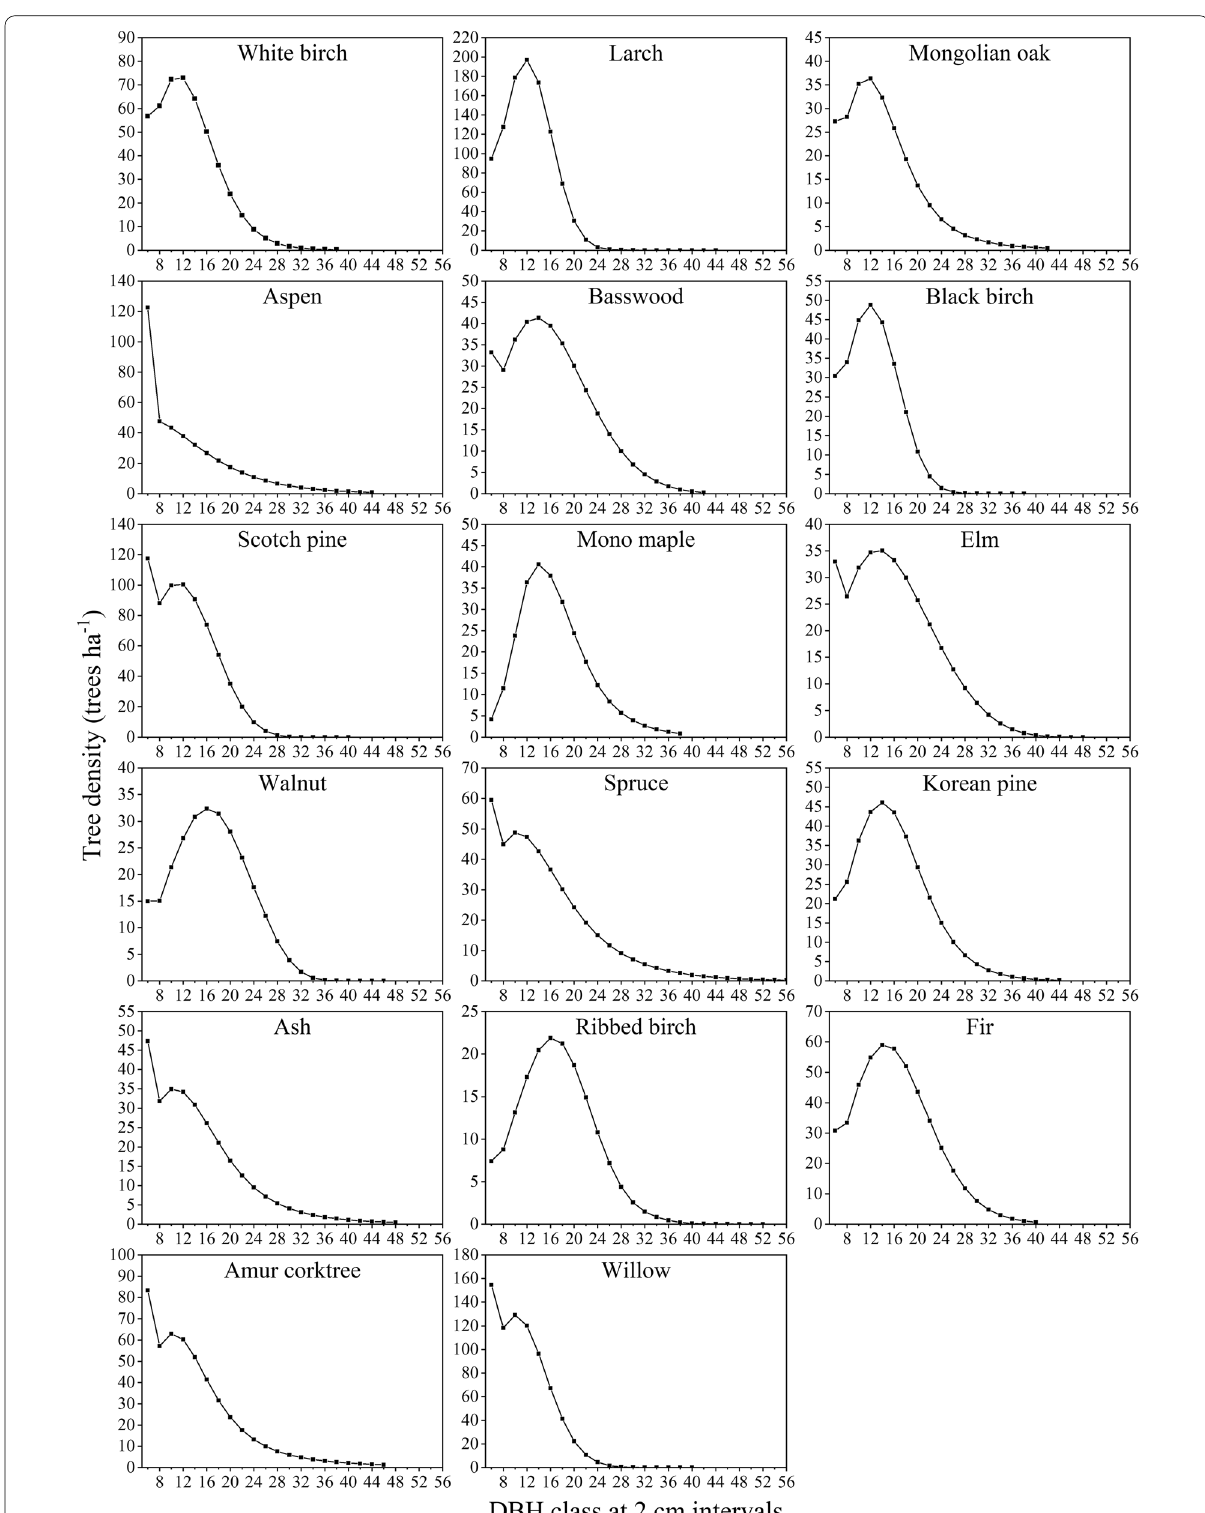
Fig. 5 Predicted tree lists by species over the forest region of Northeast China in